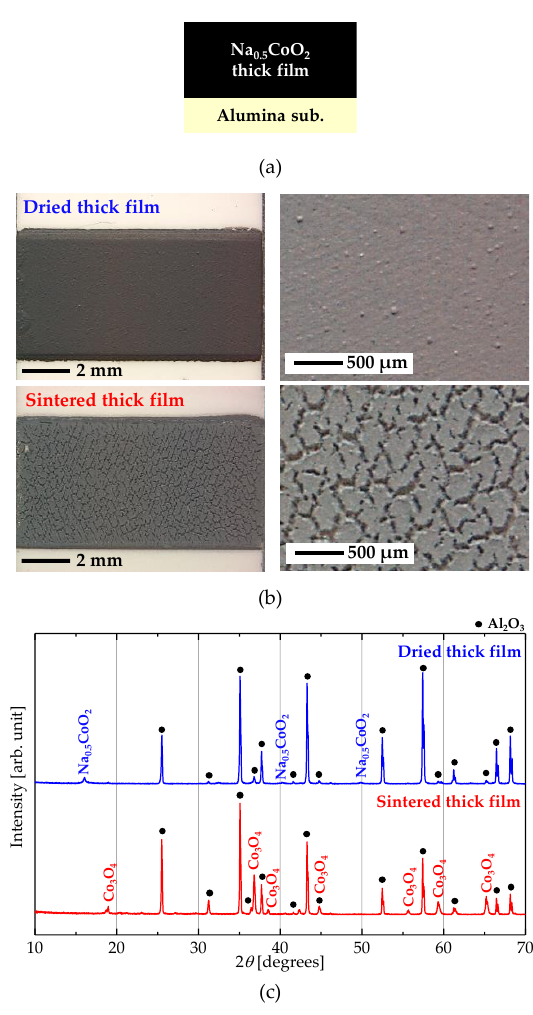
Figure 1. ( a ) Cross-sectional schematic of a printed Na 0.5 CoO 2 thick film on an alumina substrate as a first approach. ( b ) Photographs and ( c ) XRD (CuKα) patterns of a dried and a sintered Na 0.5 CoO 2 thick film prepared by the simple screen-printing process.